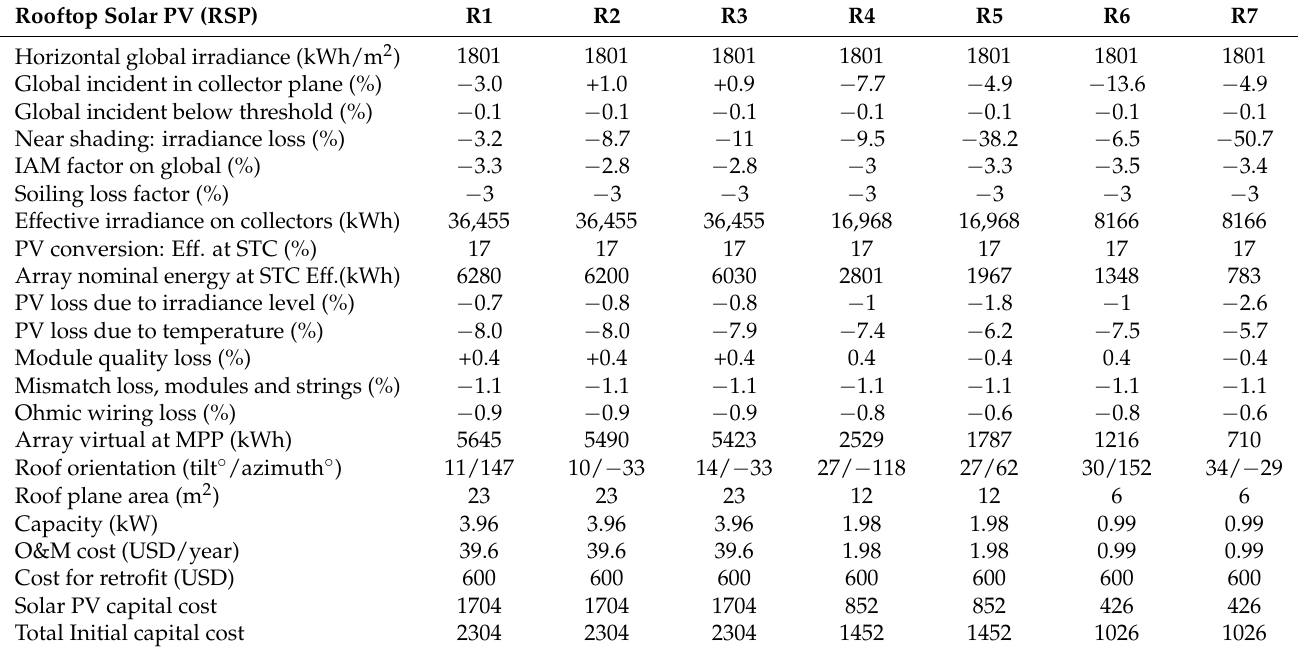
Table 7. Summary of the annual PV loss diagram and its unique characteristics from the 7-rooftop solar